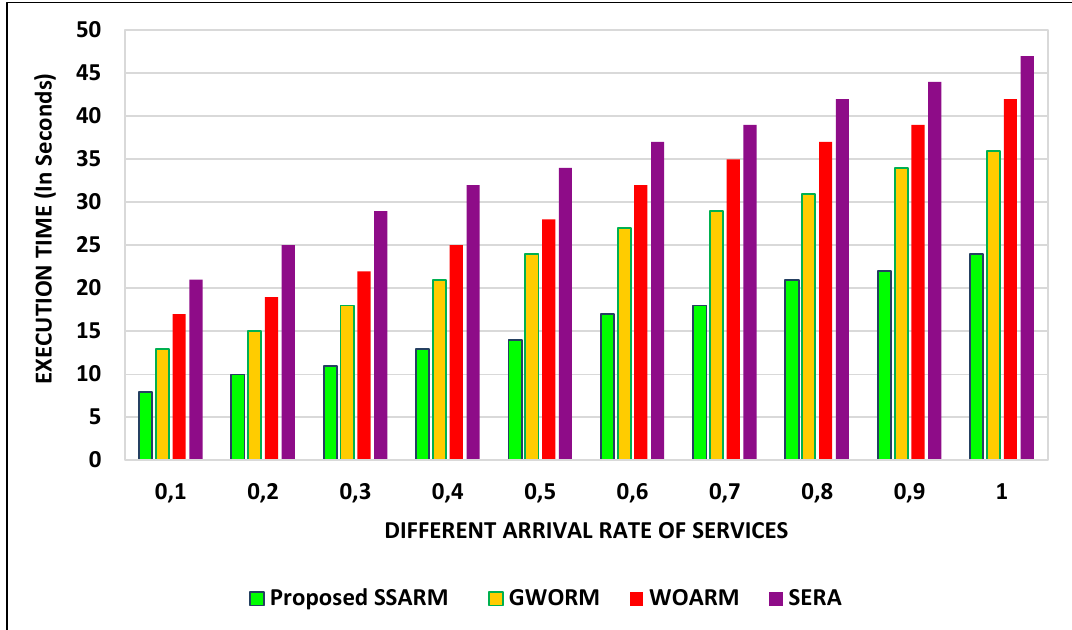
Figure 2. Proposed SSARM: Execution Time with Different Service Arrival Rates